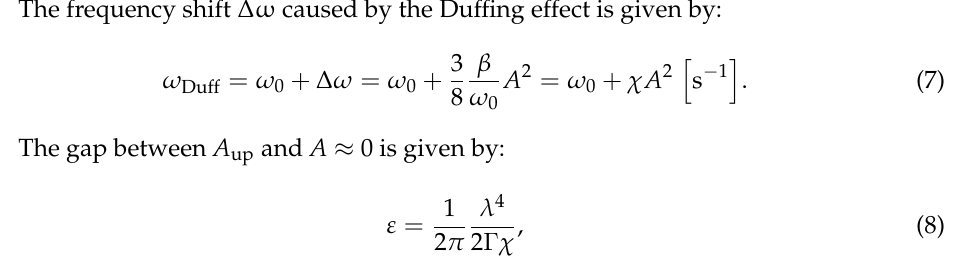
Table 1. Listing of important parameters for characterising the behaviour of Duffing oscillators. Ayela’s Model [9] Amplitude [mV] Frequency [Hz] Upward Sweep A Downward